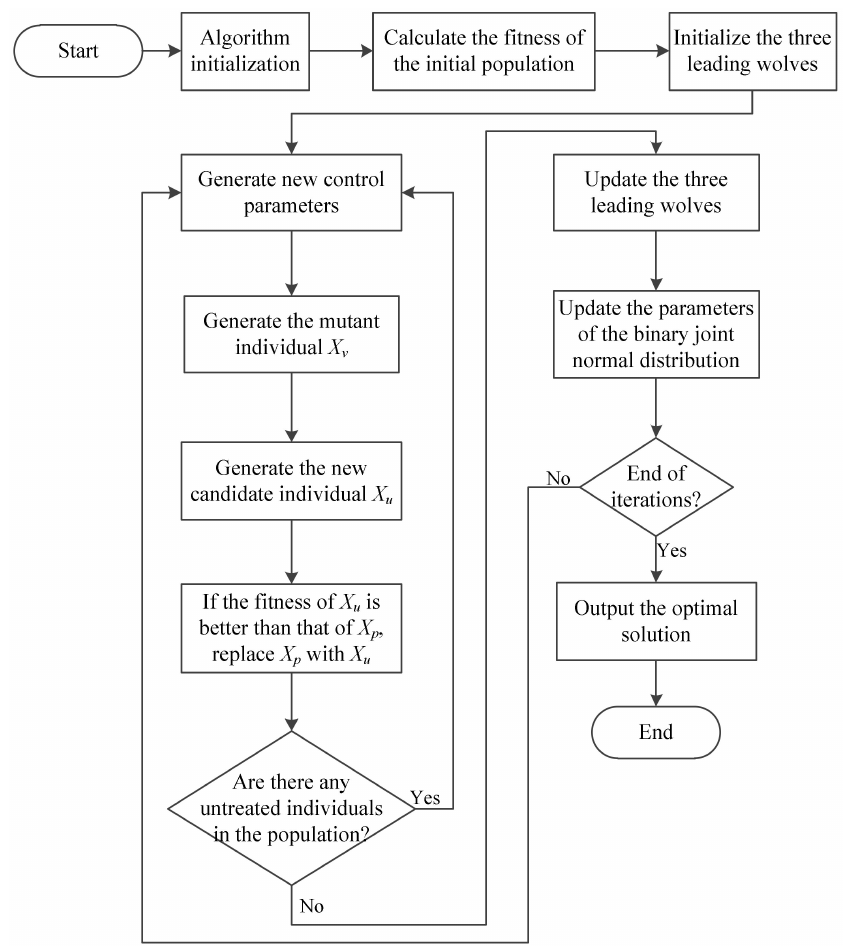
Figure 1. Flowchart of